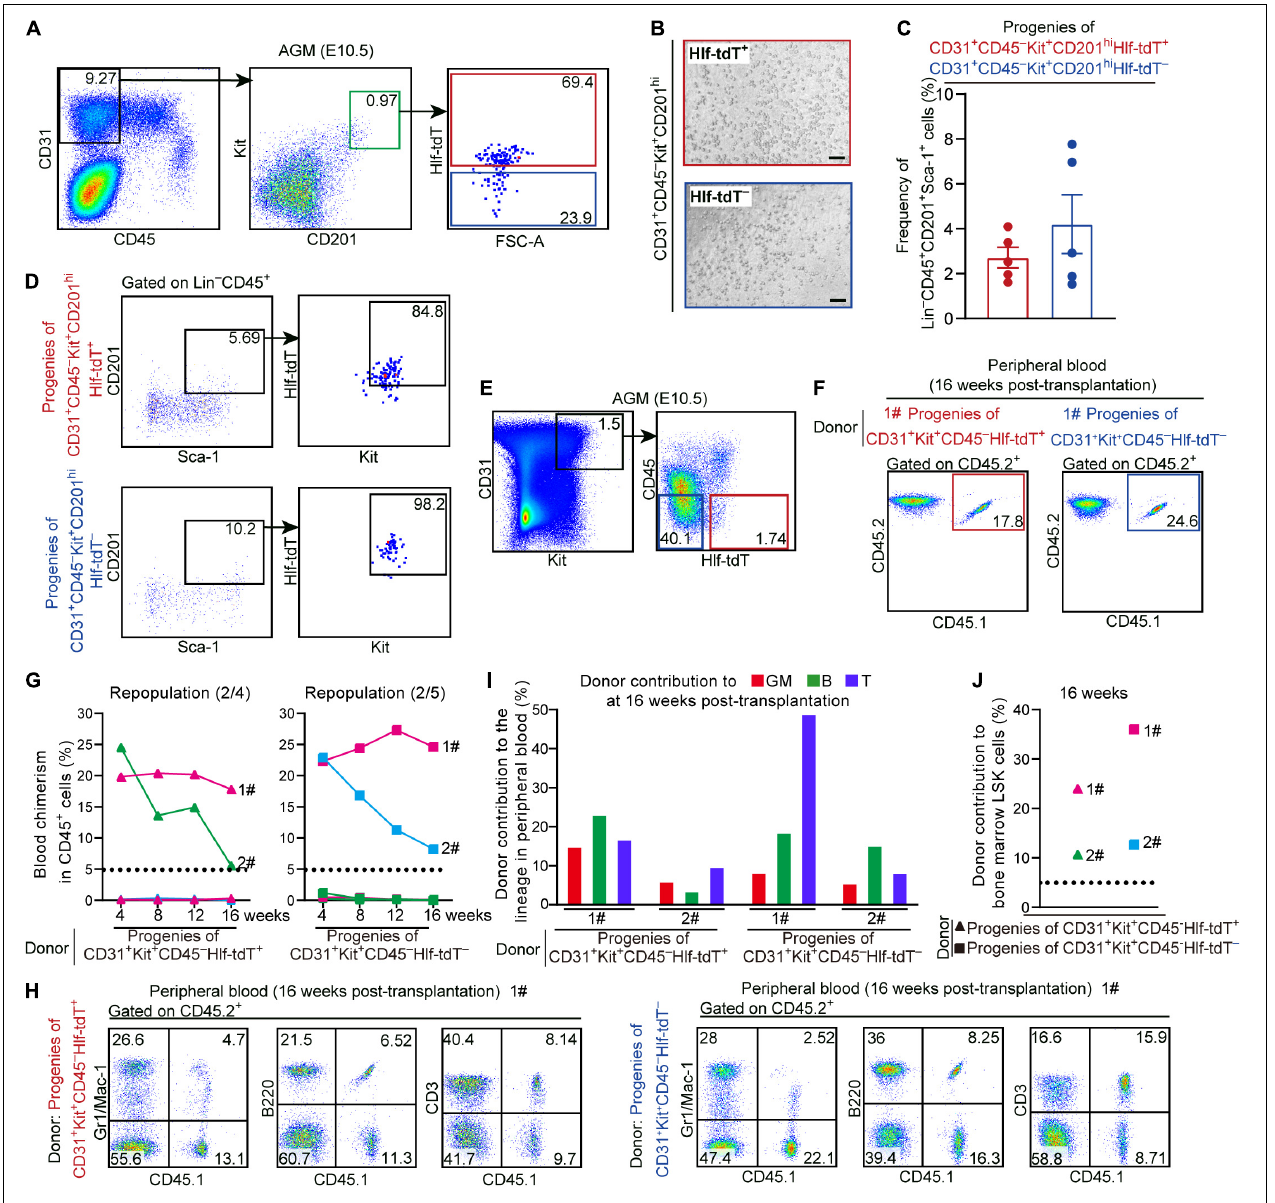
FIGURE 2 | Hlf-tdTomato expression in functional CD45 − pre-HSCs in the E10.5 AGM region. (A) Representative FACS plots showing the proportions of Hlf-tdTomato + and Hlf-tdTomato − cells in CD31 + CD45 − Kit + CD201 hi population in the AGM region of E10.5 Hlf-tdTomato embryos. Data are representative of five independent experiments. (B) Representative morphology of hematopoietic cells generated from Hlf-tdTomato + cells (red) and Hlf-tdTomato − cells (blue) within CD31 + CD45 − Kit + CD201 hi population. Scale bar, 100 µ m. (C) Graph showing the frequency of Lin − CD45 + CD201 + Sca-1 + cells generated from the indicated populations from the E10.5 AGM region after co-culture analyzed by FACS. Data are shown as means ± SEM from five independent experiments. (D) Representative FACS plots showing the expression of Hlf-tdTomato and Kit in Lin − CD45 + CD201 + Sca-1 + cells that are generated from the indicated populations of the E10.5 AGM region after co-culture. Data are representative of five independent experiments. (E) Sorting strategy for the populations from the AGM region of E10.5 Hlf-tdTomato embryos for co-culture/transplantation assay. The cell populations sorted for functional assay are denoted as colored boxes. (F) Representative FACS plots of blood chimerism of donor-derived (CD45.1 + CD45.2 + ) cells in CD45 + cells at 16 weeks post-transplantation. (G) Graphs showing the blood chimerism in CD45 + cells of each of all the recipients from 4 to 16 weeks post-transplantation. The recipients were transplanted with the culture products of CD31 + Kit + CD45 − Hlf-tdTomato + (triangle, left) or CD31 + Kit + CD45 − Hlf-tdTomato − (square, right) cells from the AGM region of E10.5 Hlf-tdTomato embryos. Numbers of repopulated/total recipients are shown in the brackets. For each transplantation assay, cells from a total of 15 Hlf-tdTomato positive embryos belonging to three independent litters (biological repeats) were sampled and cultured as donor cells, and five recipients were used. Each line represents a recipient and each color represents an independent litter (biological repeat). (H) Representative FACS plots showing proportions of donor cells and each hematopoietic lineage at 16 weeks post-transplantation. Myeloid cells (Gr1/Mac-1 + ), B cells (B220 + ), and T cells (CD3 + ) in peripheral blood are shown. (I) Bar plot representing the percentages of donor contribution to granulocytes/monocytes (GM, red), B cells (green), and T cells (blue) in the peripheral blood at 16 weeks post-transplantation. (J) Graph showing donor contribution to the bone marrow hematopoietic stem progenitor cells (Lin − Sca-1 + Kit + , LSK) of the successfully repopulated recipients at 16 weeks post-transplantation.